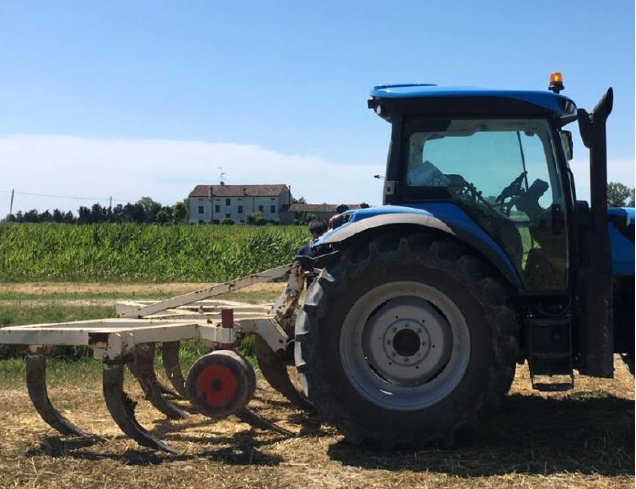
Table 2. Implement used in the validation tests.